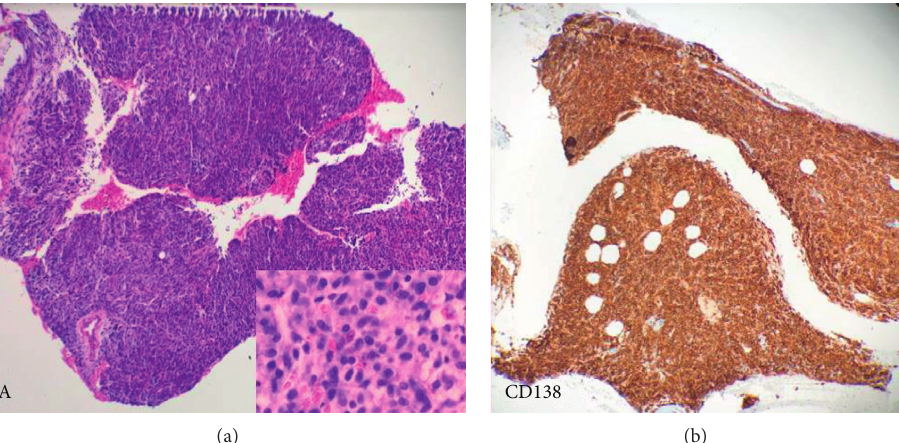
Figure 1: Representative micrograph of the bone marrow biopsy (a, b); original magnification × 20 haematoxylin eosin (H&E) stain shows a diffuse infiltration by plasma cells with suppressed trilineage haematopoiesis. These plasma cells are positive for CD138 and negative for